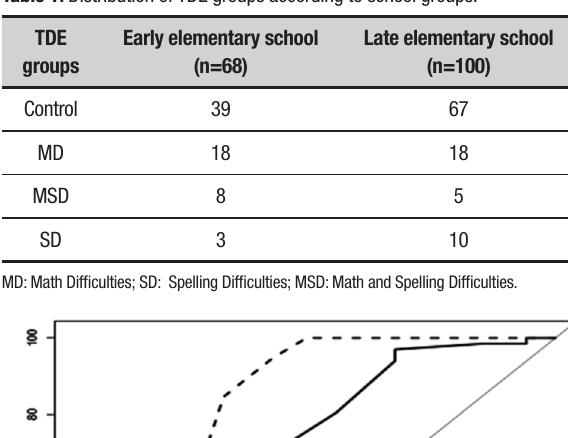
Table 1. Distribution of TDE groups according to school groups.